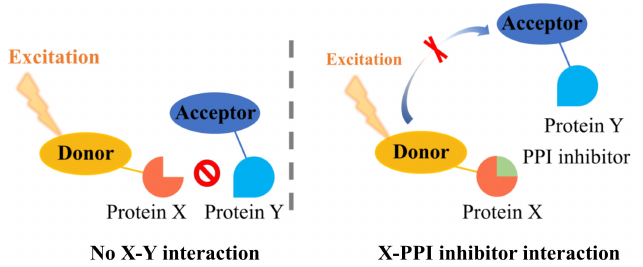
Figure 2. Principles of the proximity-based method. X and Y protein are labeled with donor and receptor moieties, respectively. Once the X–Y interaction is formed, the receptor will accept a signal from the donor and produce a detectable signal. A PPI inhibitor will block the interaction between X and Y protein, thus preventing signal